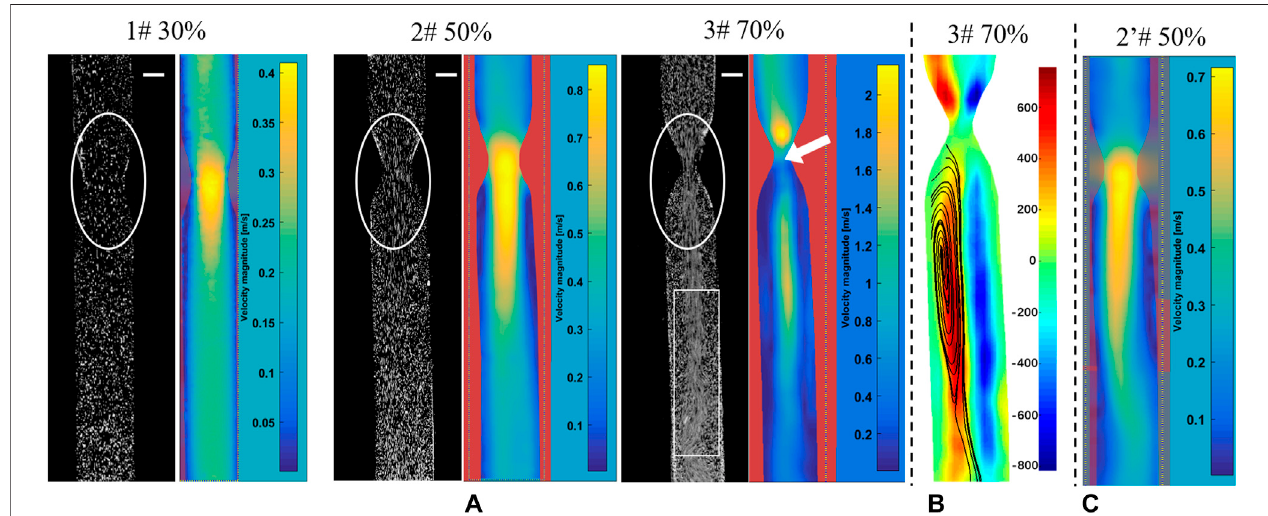
FIGURE 3 | PIV measurements to screen for silicone vessel structures with good symmetry. The snapshots in PIV experiments and fl ow distribution (A) , vorticity distribution (B) , and fl ow distribution (C) in a vessel with 50% stenosis. The bar scale is 2 mm.